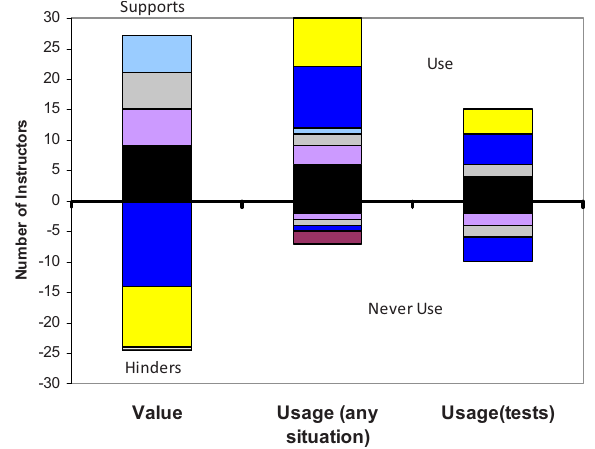
FIG. 5. (cid:1) Color (cid:2) Value and usage of problem features related to the learning goal of developing students’ ability to plan and explore solution paths. The legend is in Fig.